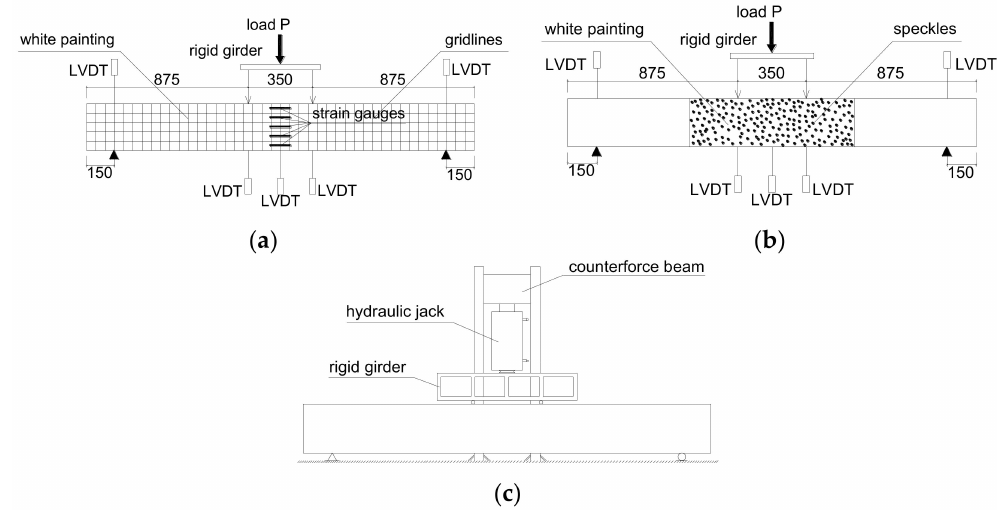
Figure 6. Beam test set-up and instrumentation (unit, mm): ( a ) lateral side A; ( b ) lateral side B; and ( c ) loading